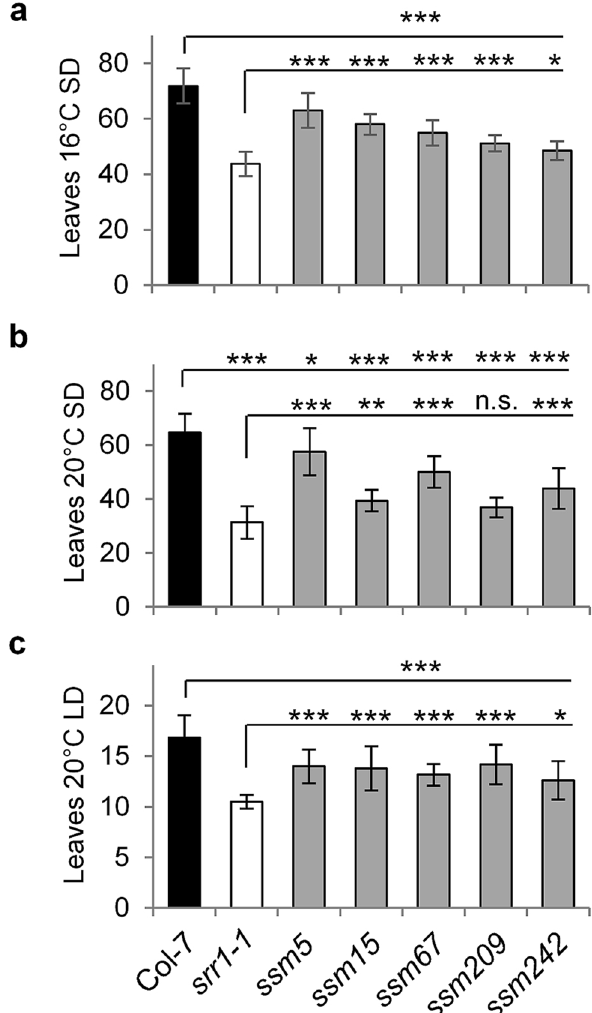
Figure 1. Flowering time of suppressor of srr1-1 ( ssm ) candidate mutants. Candidate ssm mutants with an intermediary phenotype between Col-7 wt and srr1-1 selected in an initial screen were rescreened in SDs at 16 °C ( a ), in SDs at 20 °C ( b ), and LDs at 20 °C ( c ). The number of leaves was counted for 10–12 plants each. Data are means ± s.d. To determine the statistical significance, an ANOVA followed by a post-hoc Dunnett-test was performed (* P ≤ 0.05, ** P ≤ 0.01, *** P ≤ 0.001, n.s. not